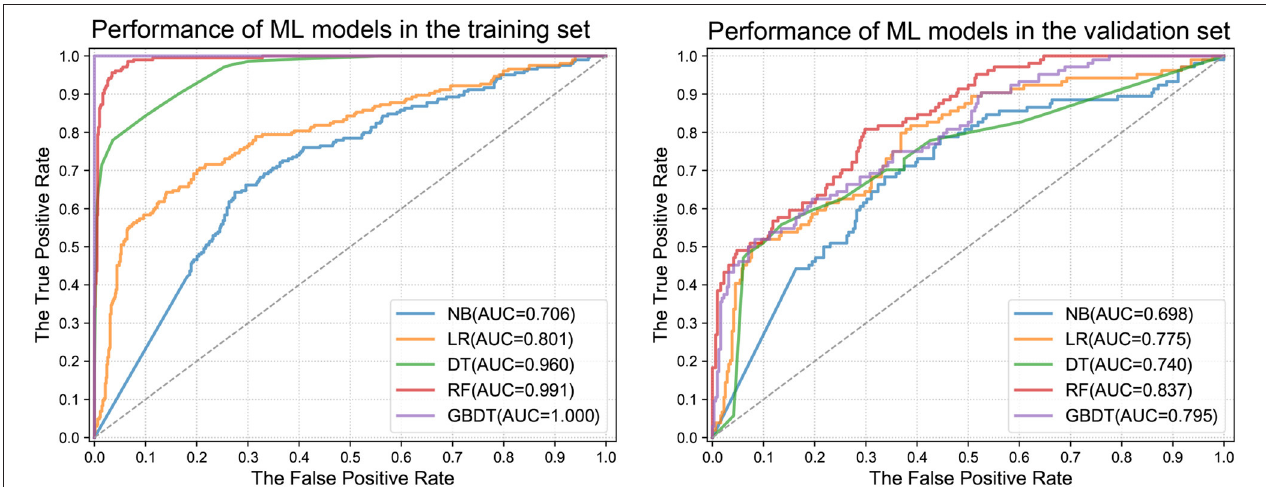
FIGURE 2 | Receiver operating characteristic area under the curves of machine learning models in the training and validation datasets. ML, machine learning; NB, Naive Bayes; LR, Linear Regression; DT, Decision Tree; RF, Random Forest; GBDT, Gradient Boosting Decision Tree; AUC, area under the curve.